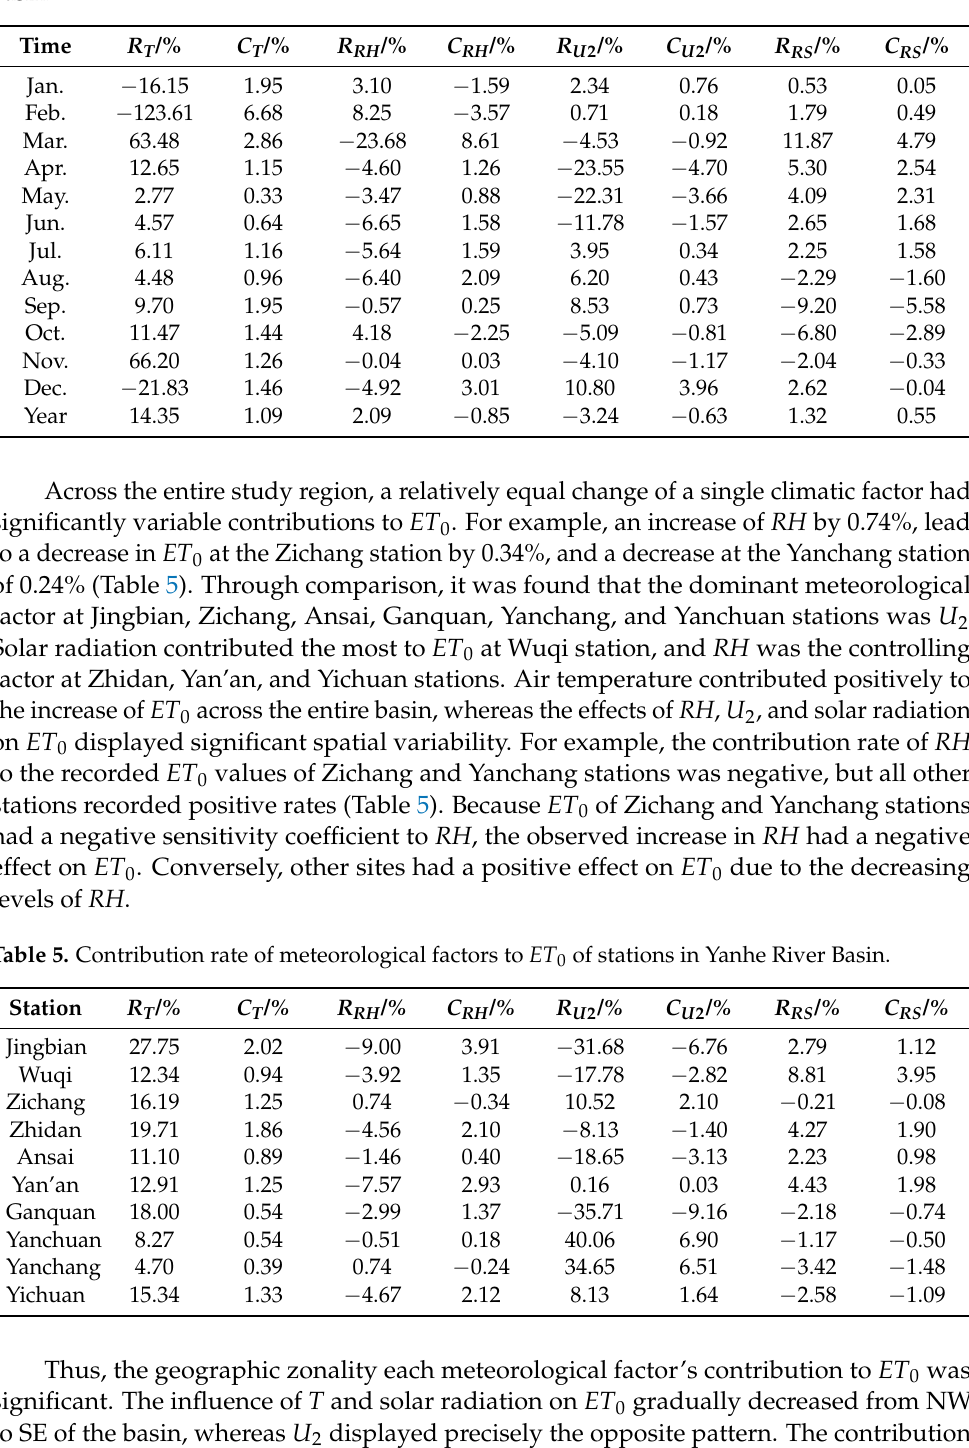
Table 4. Temporal characteristic of contribution rate of meteorological factors to ET 0 in Yanhe River Basin.